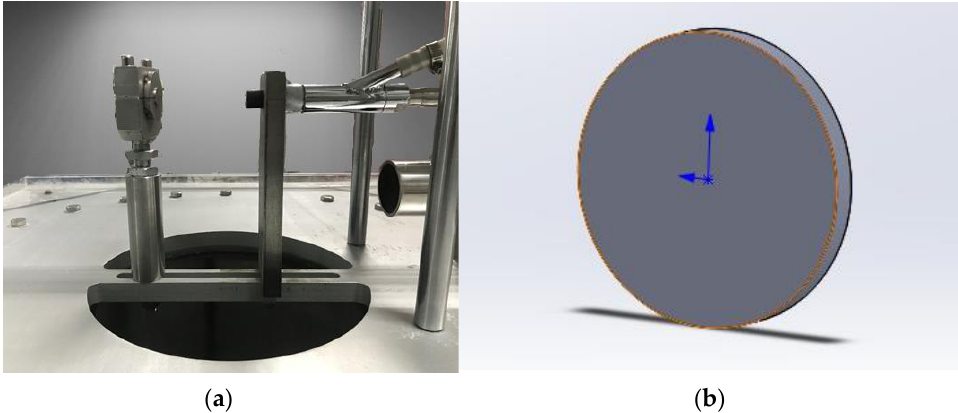
Figure 1. The experiment equipment and the specimen. ( a ) Experimental device of particle erosion, ( b ) Metal cylindrical specimen.